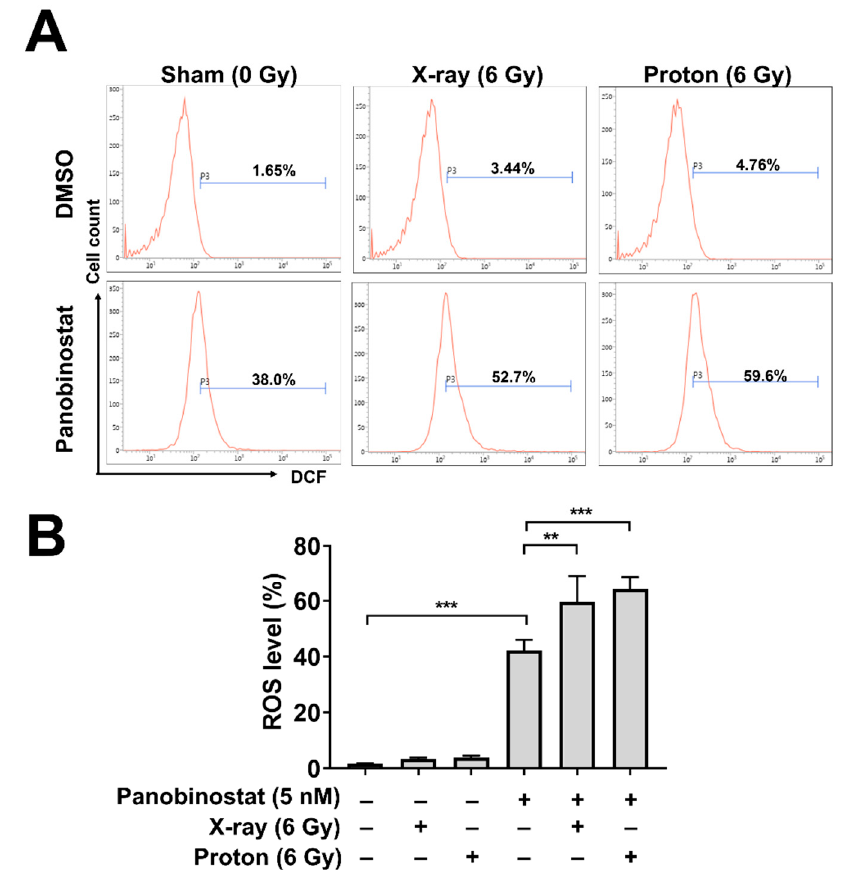
Figure 3. Effects of panobinostat combined with X-rays or protons on ROS generation in Huh7 cells. ( A ) Flow cytometry using DCFDA revealed that panobinostat increased ROS levels in combination with radiation. Representative histograms were shown. Huh-7 cells were pre-treated with 5 nM panobinostat and then incubated with DCFDA for 30 min, followed by irradiation with 6 Gy of X-rays or protons. Flow cytometry was performed 72 h post-irradiation. ( B ) Quantification of ROS levels in Huh7 cells. The data represent the mean ± S.D. (n = 3); ** p < 0.01; *** p < 0.001.